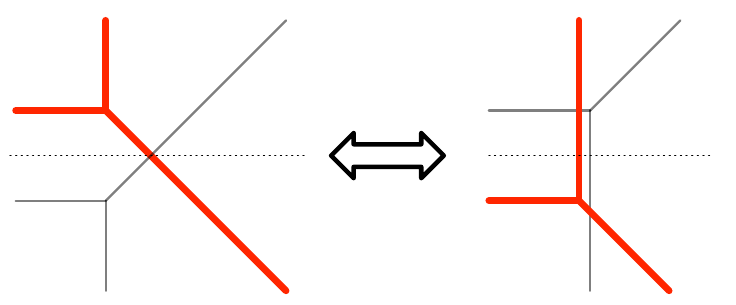
Figure 14. Interpretation of the (cid:13)op transition in (cid:12)gure 13